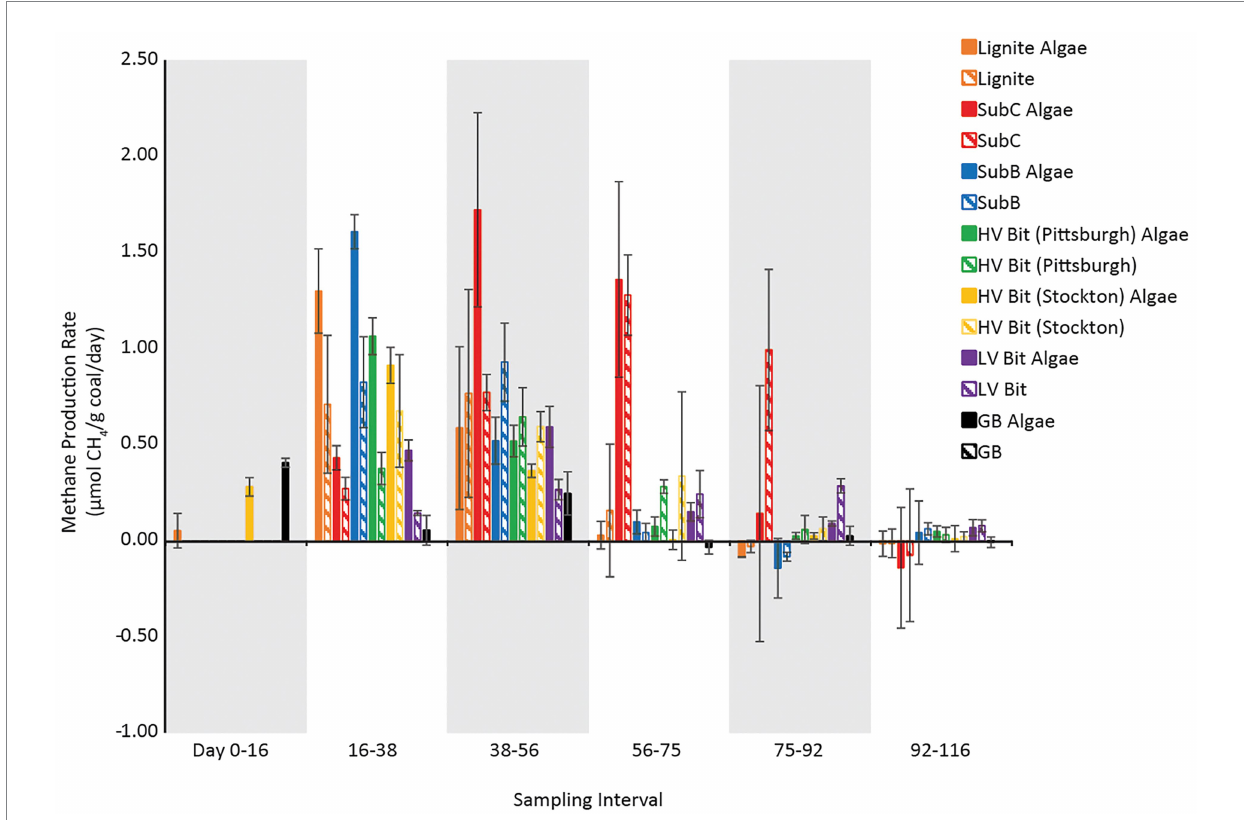
FIGURE 3 Methane production rates versus time for amended and unamended microcosms. Algae extract was added to a final concentration of 0.1 g/l. Error bars represent one standard deviation of measurements from triplicate